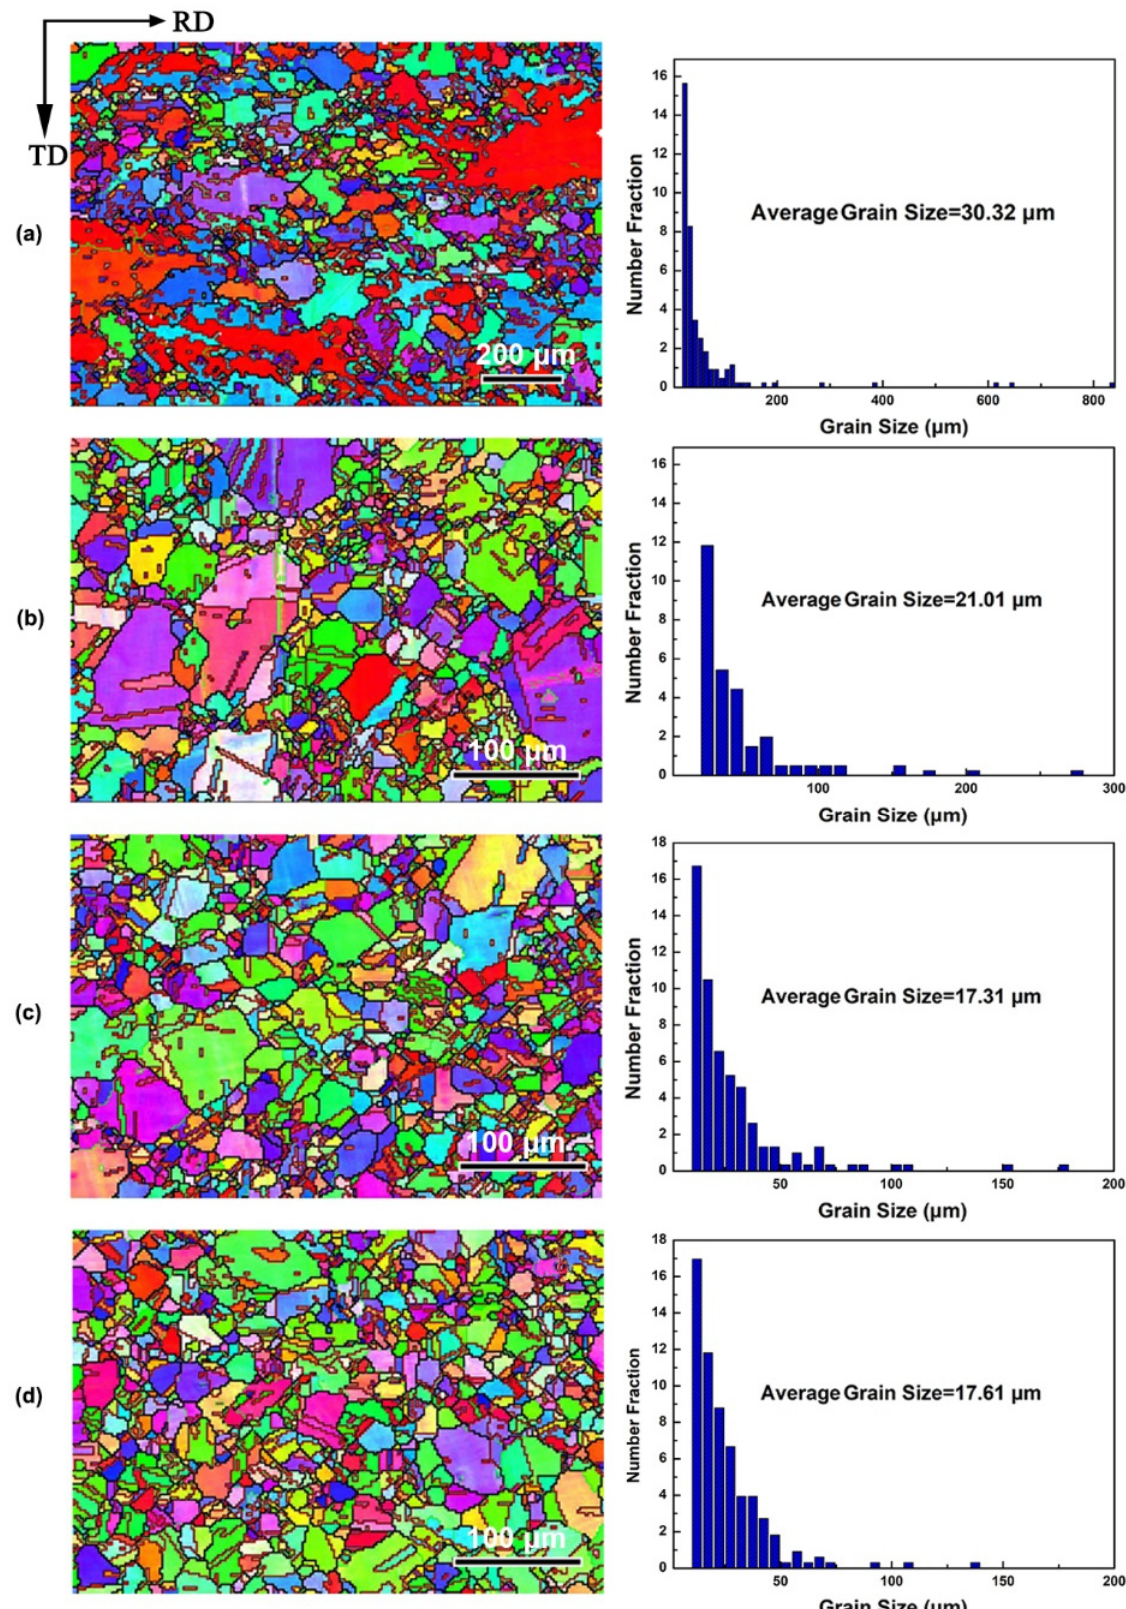
Figure 6. EBSD orientation maps and corresponding grain size distributions of the final cold rolled Cu specimens, ( a ) pure Cu, ( b ) P23, ( c ) P52, ( d ) P100, respectively.